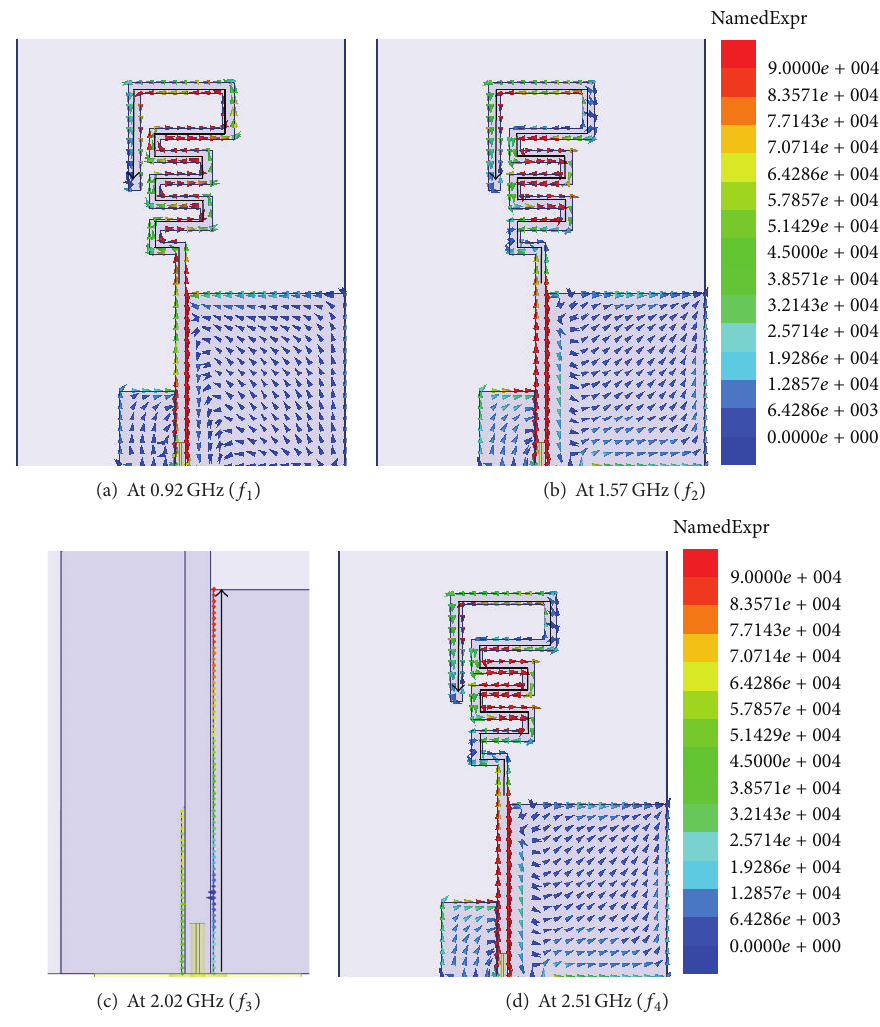
Figure 3: Simulated current distribution of the proposed antenna. (a), (b), and (d) electric current. (c) magnetic current.